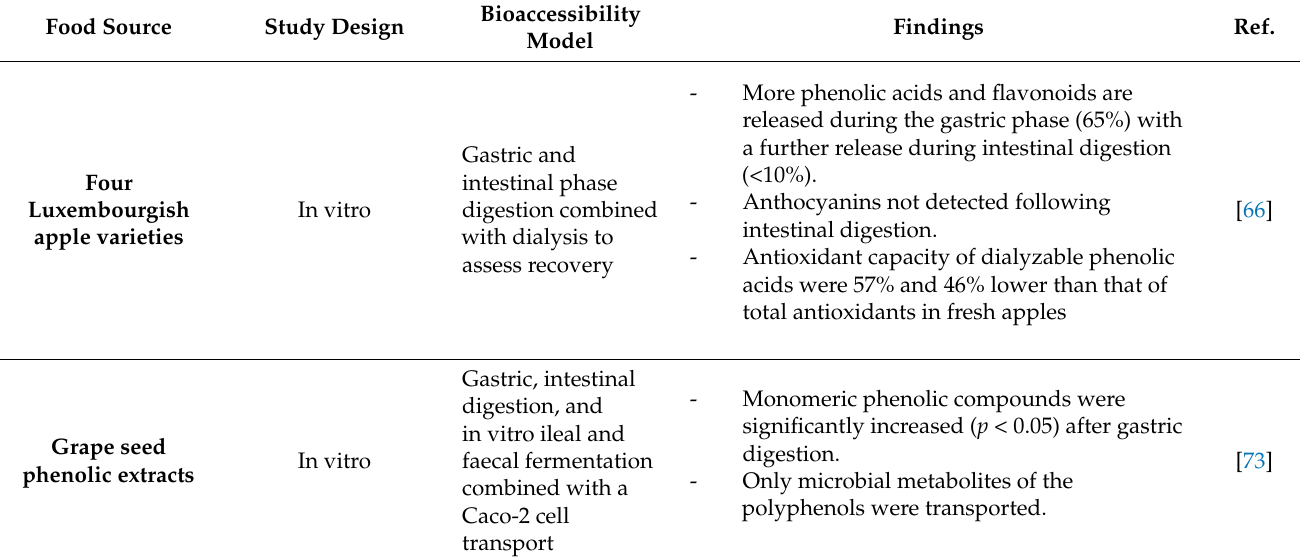
Table 2. Impact of GI digestion on dietary polyphenol